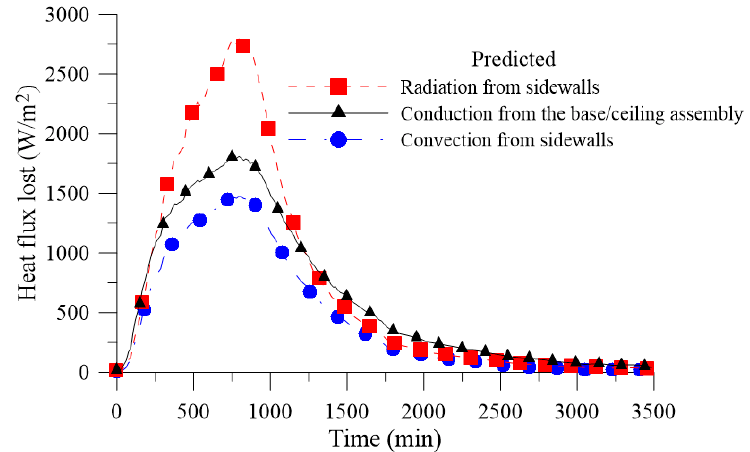
Figure 11. Specific heat flux lost by the kiln as a function of time.